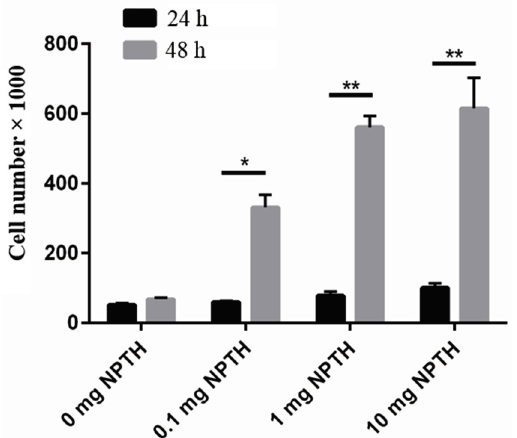
Figure 5. Effect of NPTH treatment on cell viability of hFOB cells. Bars represent